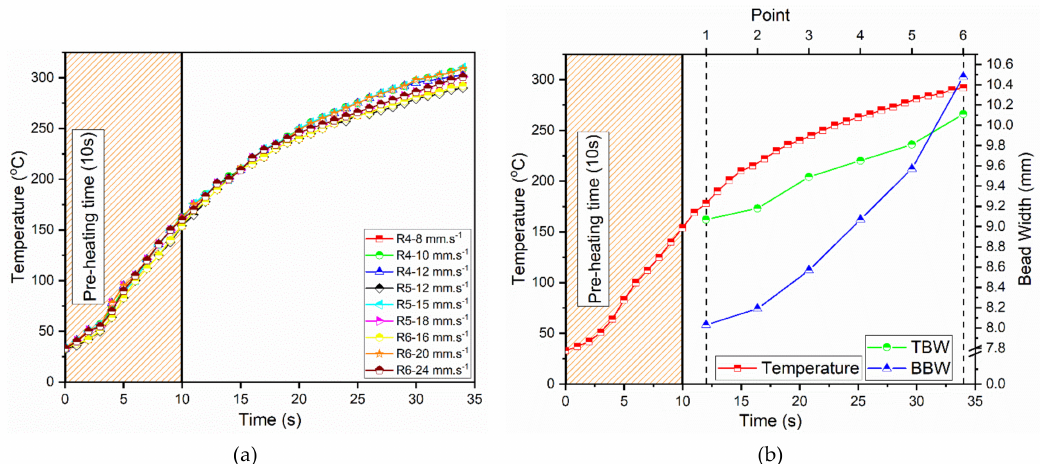
Figure 6. ( a ) Temperature histories at Heat Affected Zone (HAZ) region, and ( b ) temperature history vs. top bead width (TBW) and back bead width (BBW) at R4-8 mm·s − 1